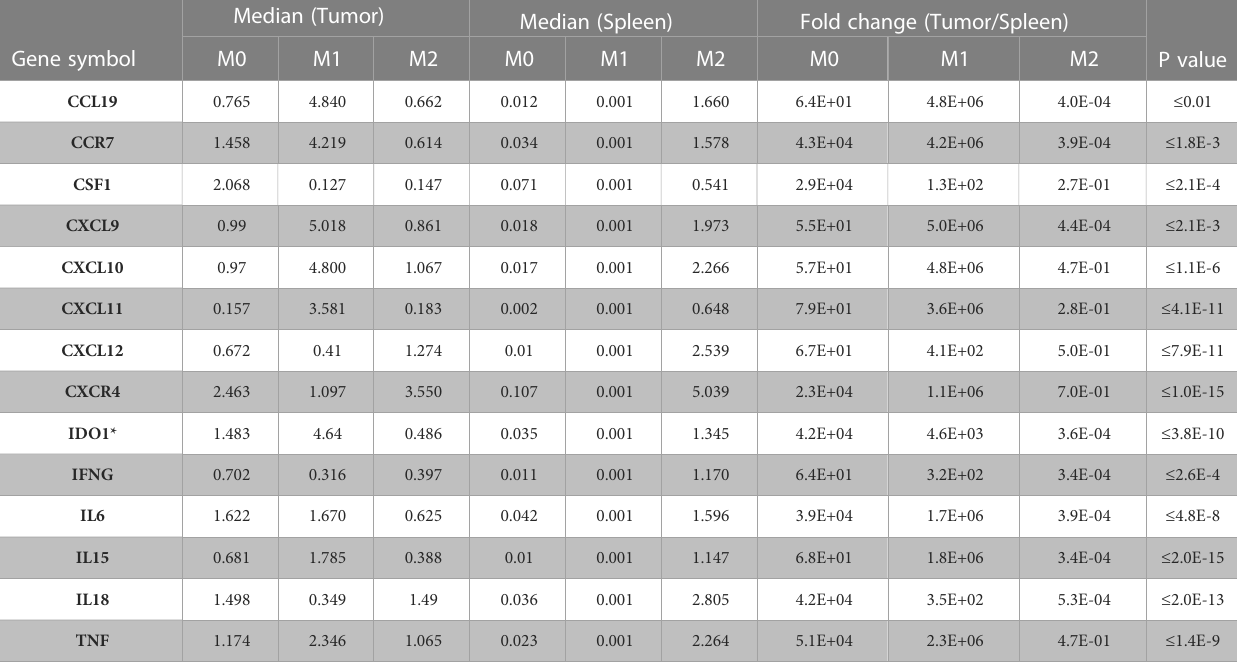
TABLE 2 Differentially expressed cytokines in the three macrophage subtypes in DLBCL.